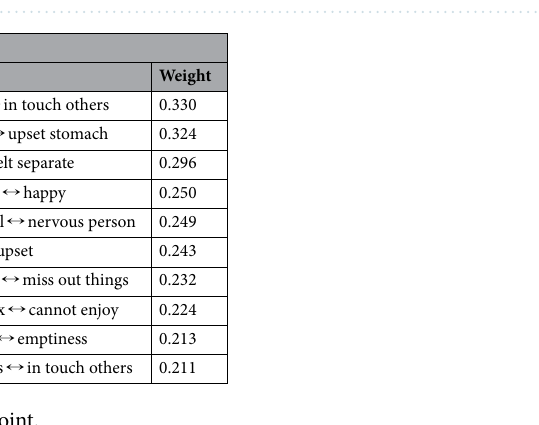
Figure 3. Average (absolute) edge values between and within questionnaires at ( A ) pre-COVID-19, ( B ) Lockdown and ( C ) of the difference between both timepoints. The diagonal represents the average (absolute) edges values within questionnaires.